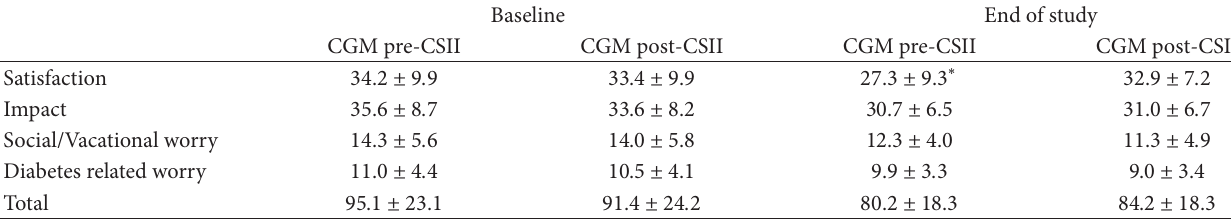
Table 3: Diabetes Quality of Life Questionnaire